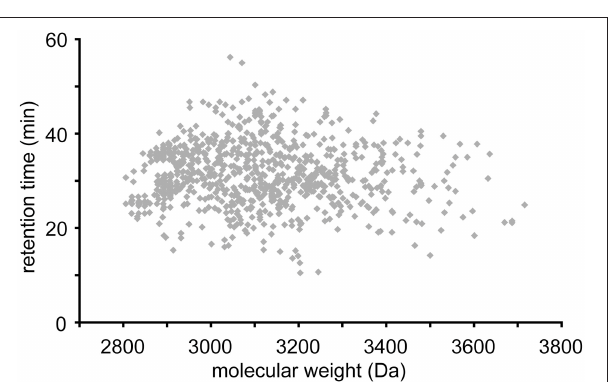
FIGURE 4 | Scatter plot data of all detected cyclotides. Each symbol represents one of the 1043 cyclotides detected in the 143 species. Some cyclotides were found in more than one species. The vertical clusters of peaks around 2900 Da reflect the more common cyclotides such as varv A, varv F, and kalata B1. Masses range from 2800 to 3700 Da and retention times range from 15 to